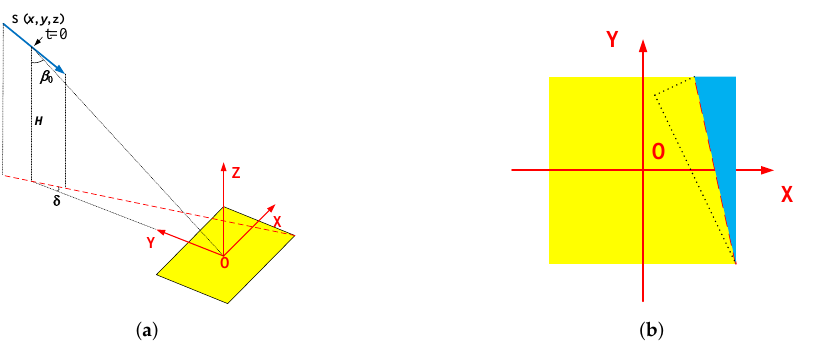
Figure 13. Mechanism-based analysis of folding phenomenon with ( a ) EHS SAR geometry and ( b ) the imaging range on the ground.